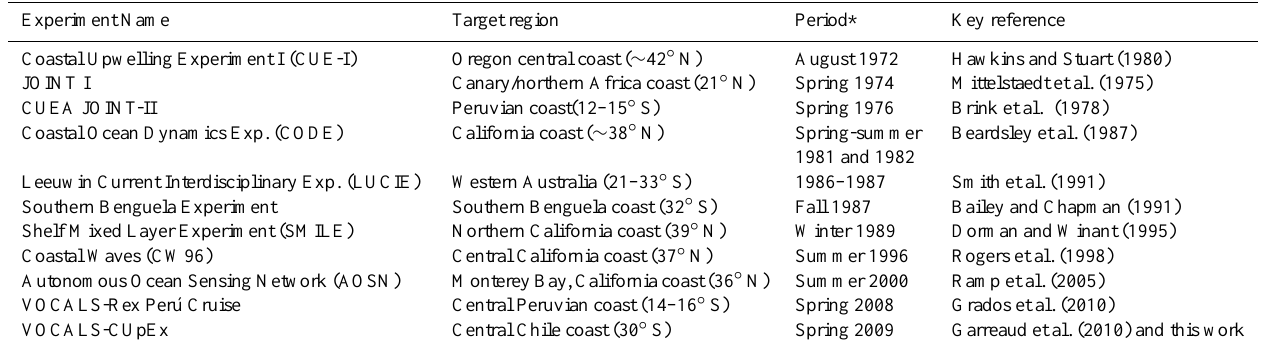
Table 2. Summary of selected meteorological/oceanography experiments conducted in eastern boundary upwelling systems.